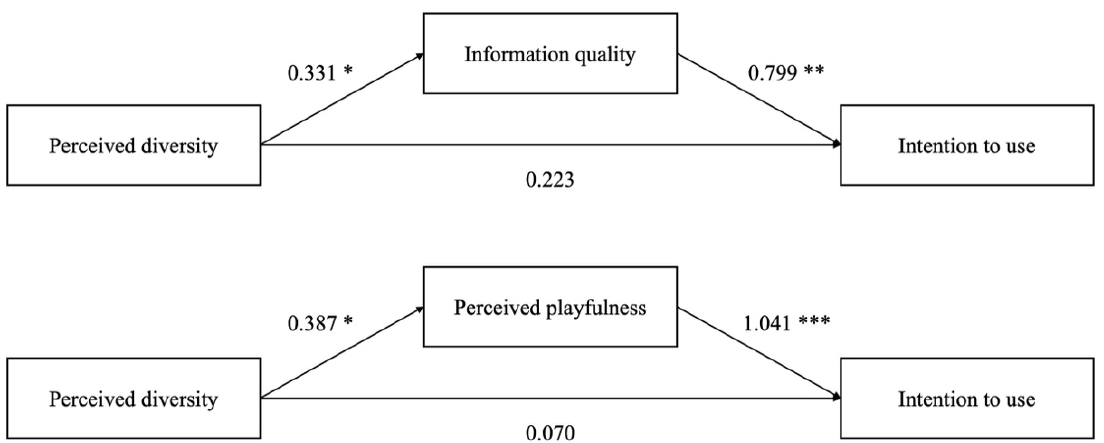
Figure 5. Path coefficients and significance (* p < 0.05, ** p < 0.01, *** p < 0.001).